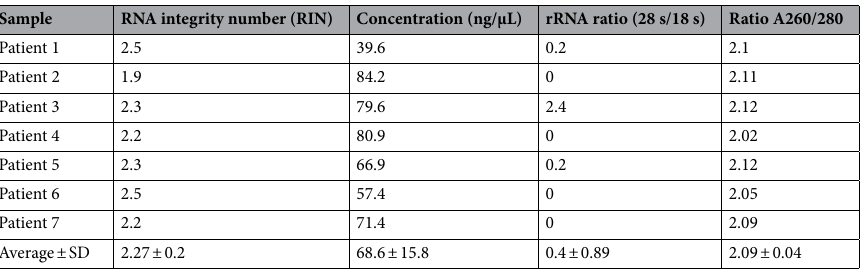
Table 4. RNA extraction from human post-mortem tissue resulted in low-integrity total RNA.